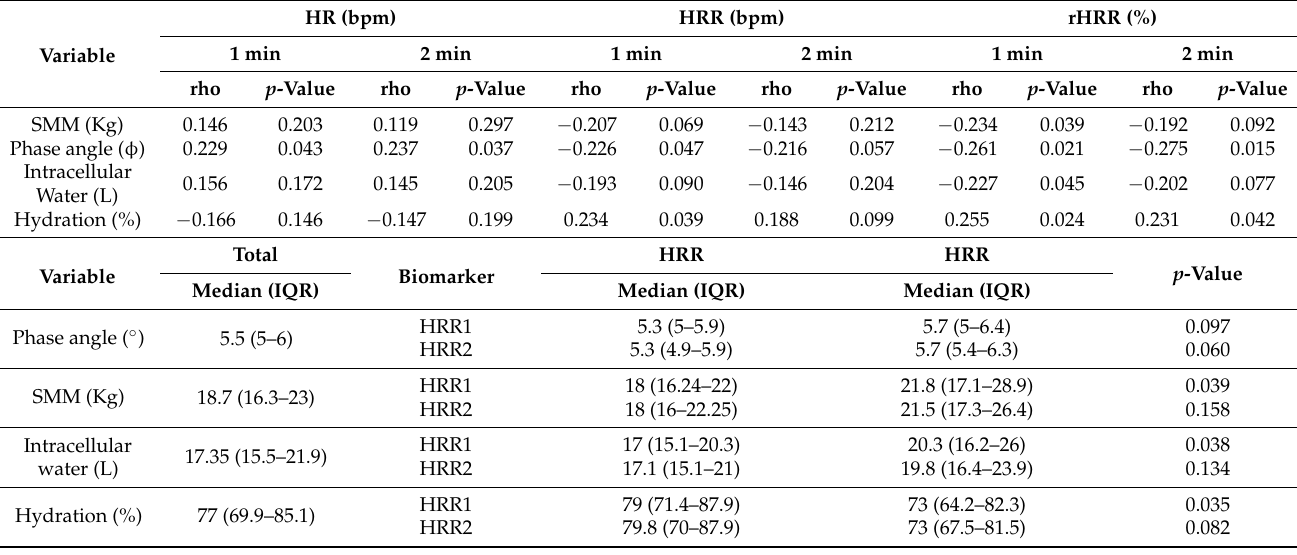
Table 4. Correlation between heart rate, heart rate recovery at 1 and 2 min, relative heart rate recovery, and body composition parameters. Comparative differences in body composition between normal and abnormal